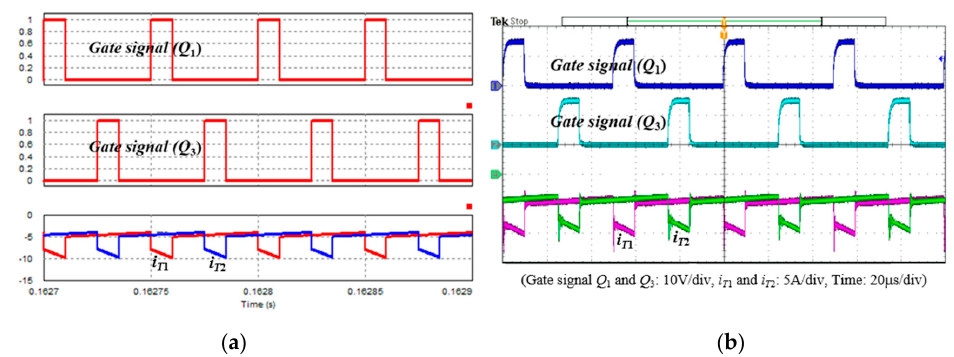
Figure 18. Waveforms of the switching gate signals and the primary-side currents of the coupled inductor in the UC discharging mode with D d = 0.2: ( a ) simulated and ( b ) experimental.